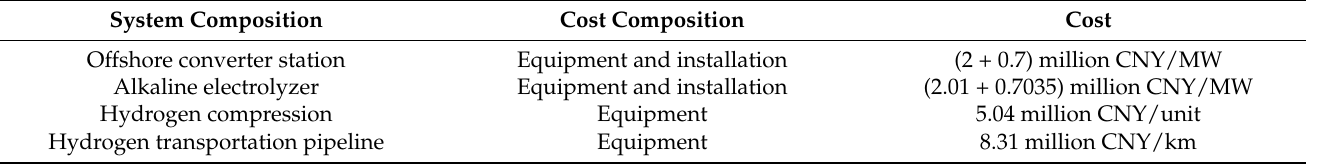
Table 2. Economic parameters of an offshore platform hydrogen production and pipeline hydrogen transmission